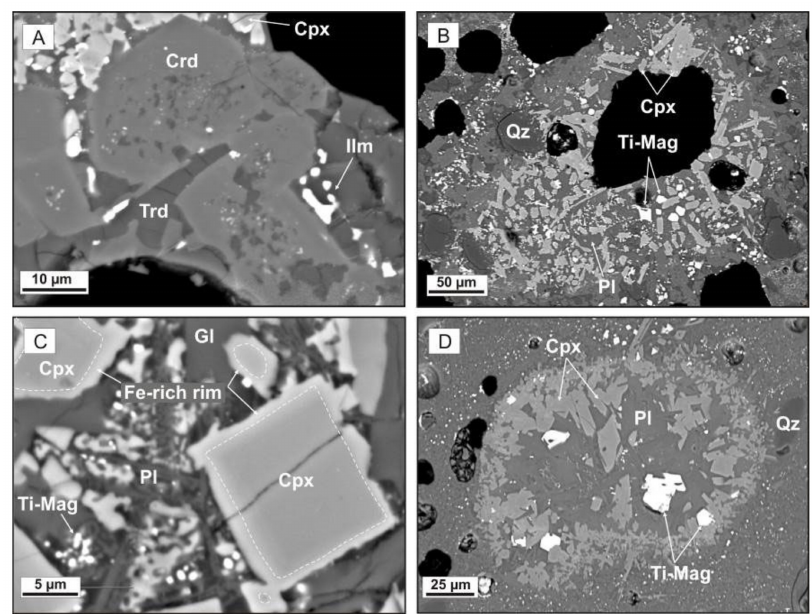
Figure 6. BSE images of newly formed aluminosilicate minerals from paralavas. ( A ) Aggregate of prismatic Fe-rich cordierite crystals with tridymite inclusions, tridymite laths, zoned pigeonite crystals, and ilmenite globules. ( B ) Pigeonite crystals and ferrous spinel isometric and hopper-like crystals localized in a glass matrix around pores. Undermolten relict detrital quartz grains with perlitic cracks. ( C ) Zoned pigeonite crystals and plagioclase laths in siliceous Al–K-rich glass. ( D ) Cluster of ferrous spinel and pigeonite crystals, and plagioclase laths. Crd = cordierite, Cpx = pigeonite, Gl = glass, Ilm = ilmenite, Pl = plagioclase, Qz = quartz, Ti-Mag = intermediate members of the magnetite–ulvöspinel solid solutions, Trd = tridymite.